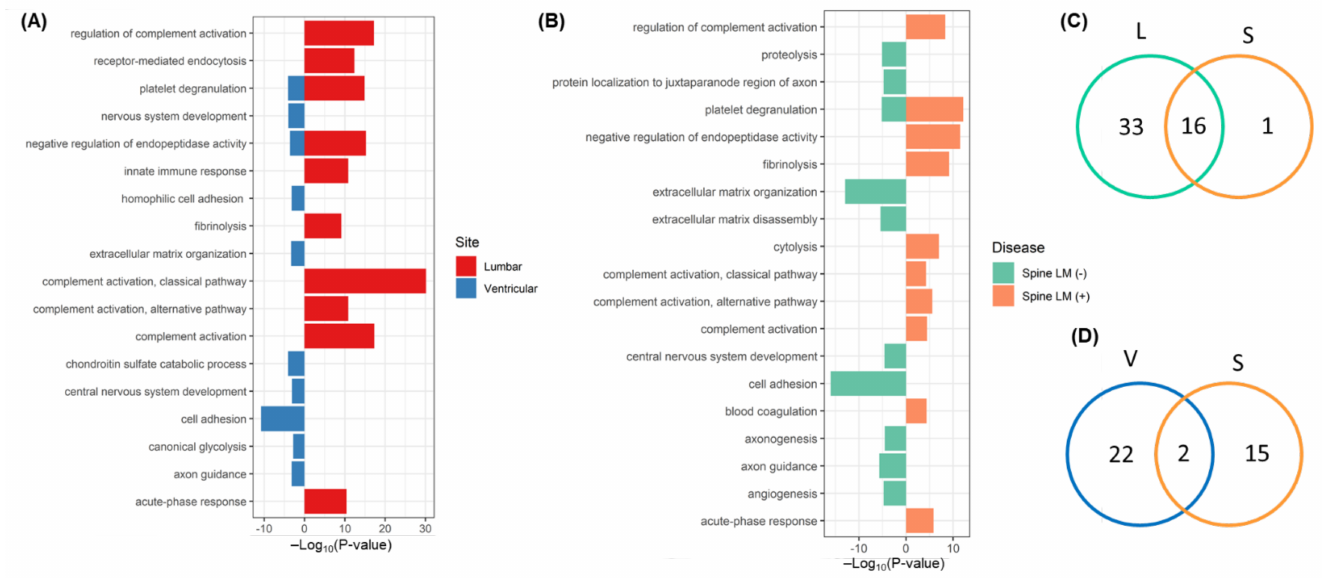
Figure 6. Protein enrichment analysis for the Gene Ontology database biological processes using the top 10 pathways for ( A ) lumbar and ventricular CSF, and ( B ) spinal LM (+) and LM ( − ) CSF. Venn diagram illustrating the number of differentially expressed proteins comparing ( C ) ventricular and spinal LM (+) CSF and ( D ) lumbar and spinal LM (+)